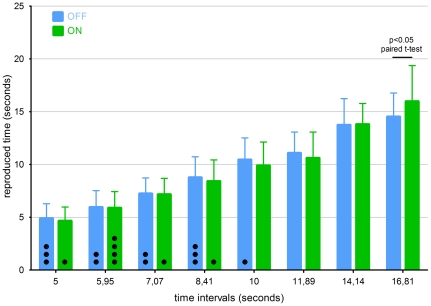
Mean interval reproductions.Mean reproduced durations ± SD for all subjects in the OFF (blue) and ON (green) conditions. Direct comparison between the ON and OFF condition was significant only for the 16.8 s interval (paired t-test, p<0.05). Dots inside of the bars represent missed responses for each interval and condition.